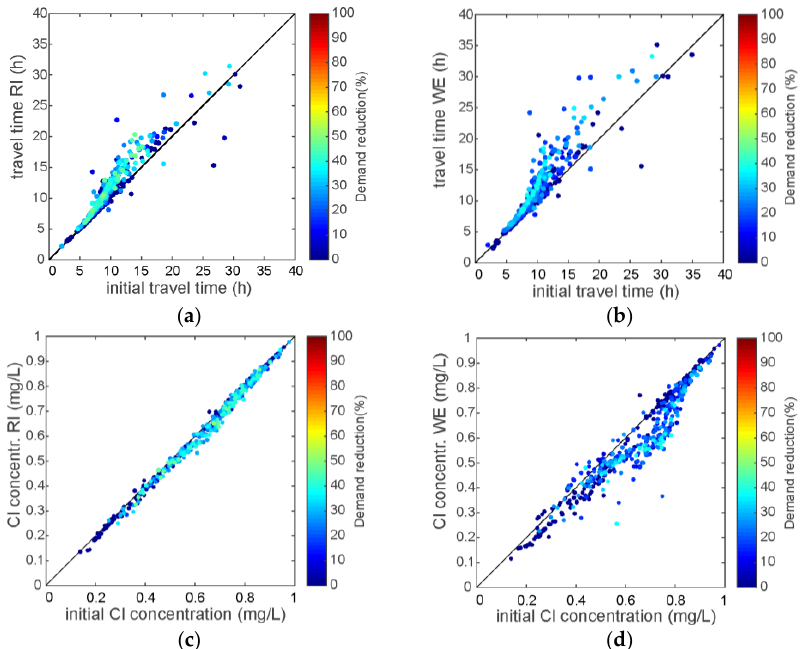
Figure 7. Systematic node-wise comparison of the initial conditions with the scenarios RI and WE with colours indicating the demand reductions for ( a ) and ( b ) travel time in the network; ( c ) and ( d ) chlorine